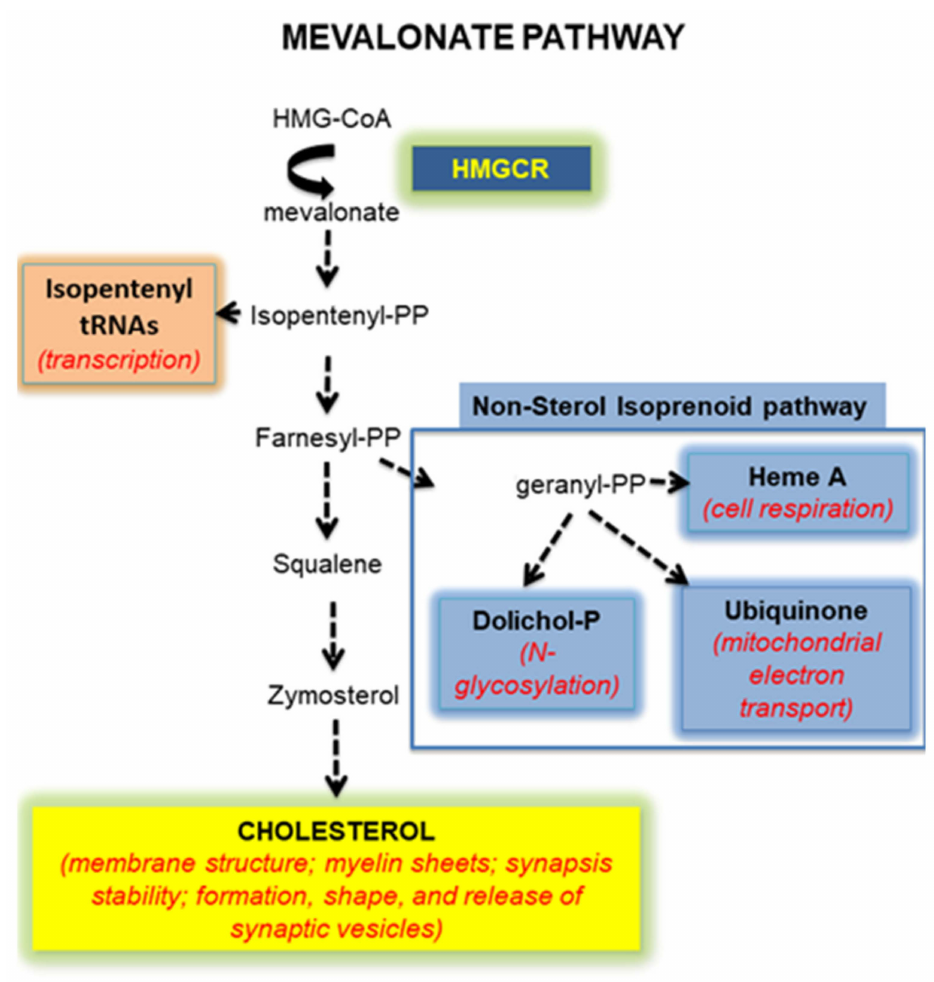
Figure 1. A schematic illustration of the mevalonate